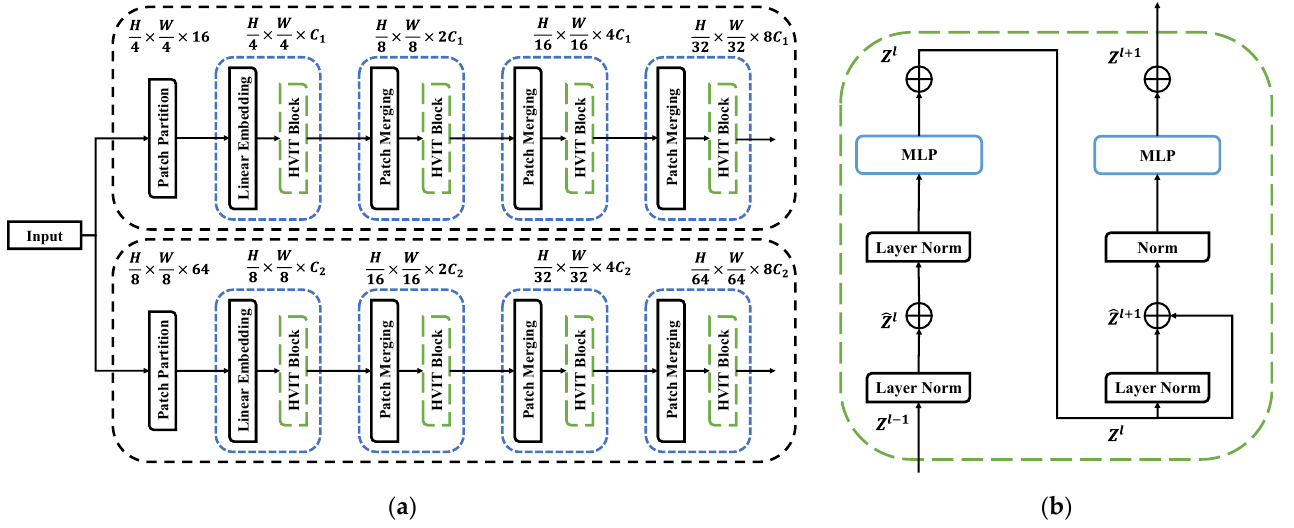
Figure 5. Networks used for degradation feature extraction: ( a ) Network’s structure; ( b ) HVIT block.